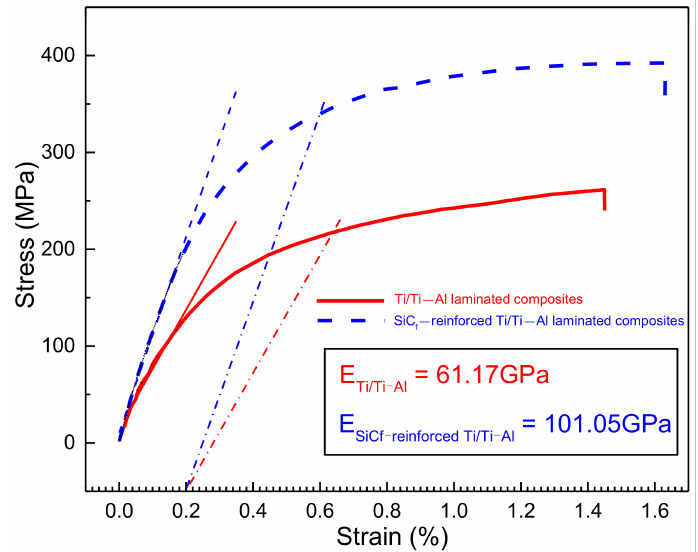
Figure 11. Stress–strain curves of the fabricated laminated